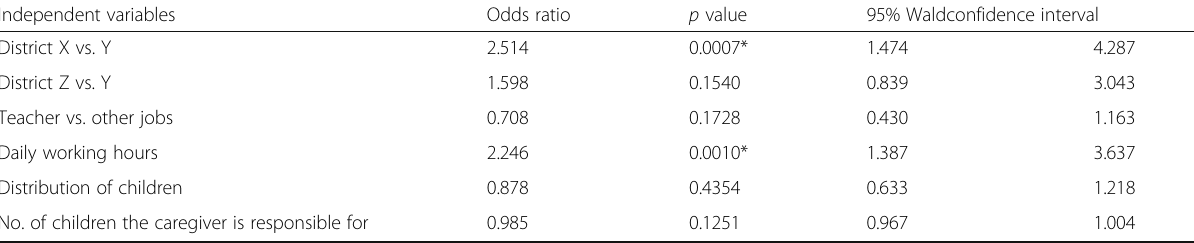
Table 5 Predictors of infection control practices of caregivers in DCCs (Alexandria, 2015) Independent variables Odds ratio p value 95% Waldconfidence interval District X vs.